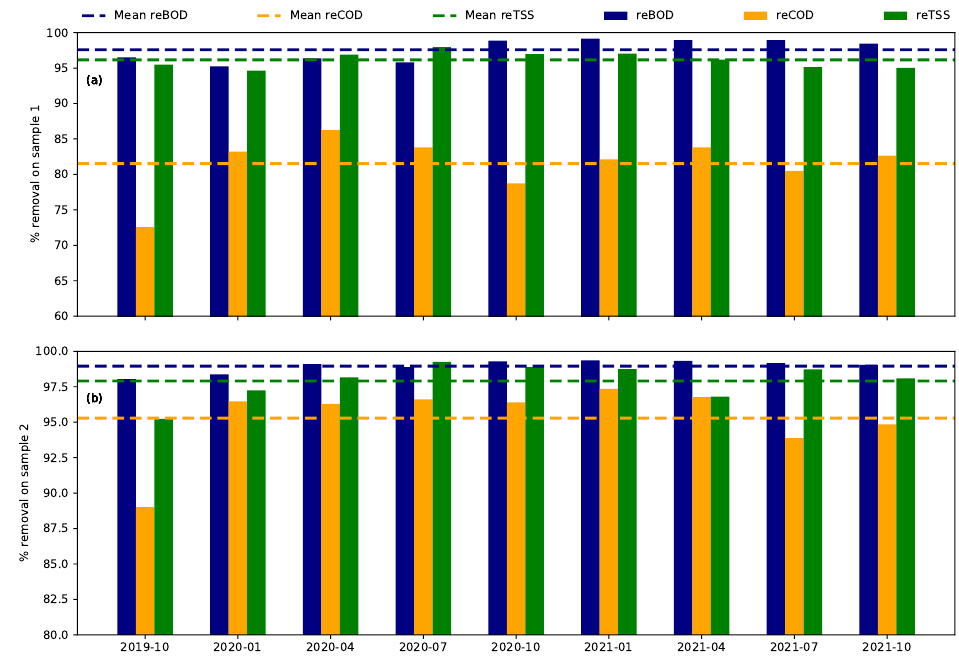
Figure 4. Percentage removal of BOD, COD, and TSS (reBOD, reCOD, and reTSS, respectively) in water sampled after the compost beds ( a ) and after the active carbon beds ( b